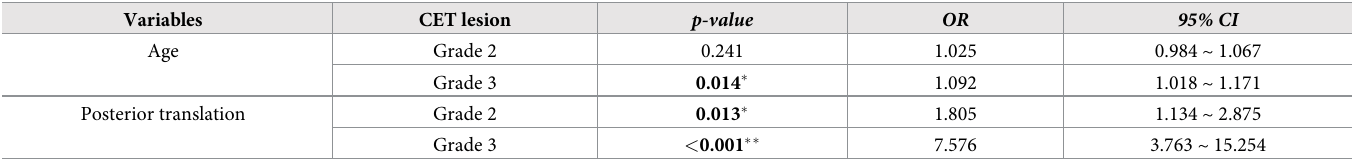
Table 4. Factors associated with the severity of the common extensor tendon